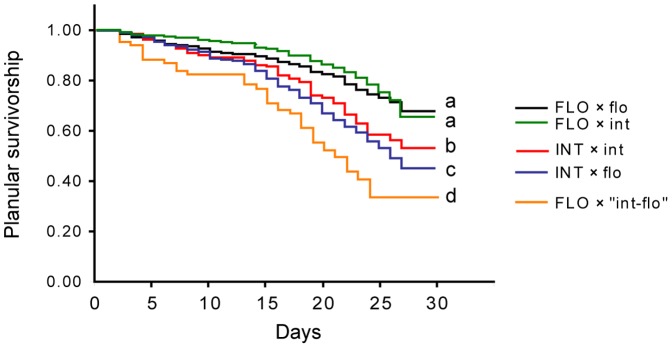
The larval survival curves of mating pairs.flo, A. florida; int, A. intermedia; “int-flo,” A. sp. “int-flo.” Uppercase text indicates eggs and lowercase text indicates sperm. Survival curves with different symbols (a–d) show significant differences in survivorship.